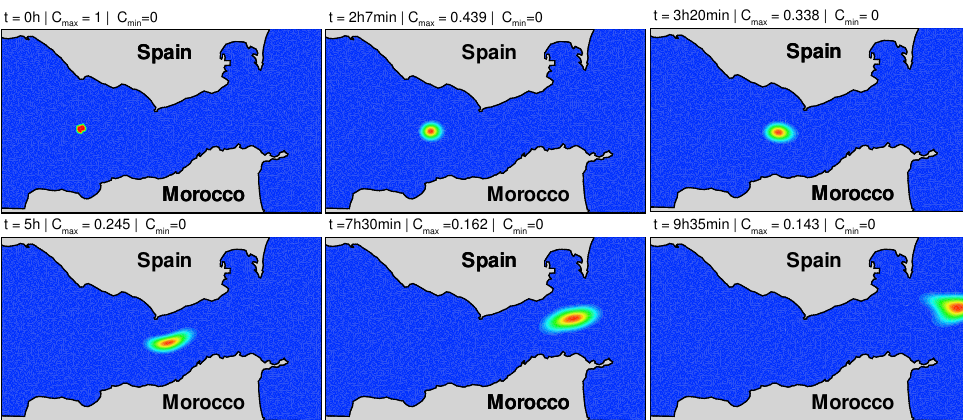
Figure 9. Position and concentration of the pollutant released in the Strait of Gibraltar at differ- ent